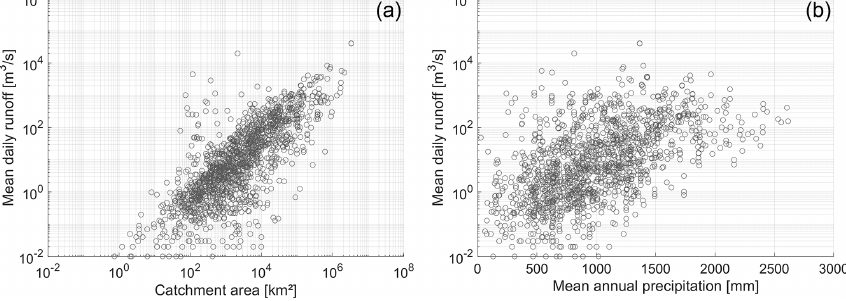
Figure 6. Relationship between mean daily river discharge and catchment area (a) and mean annual precipitation (b)